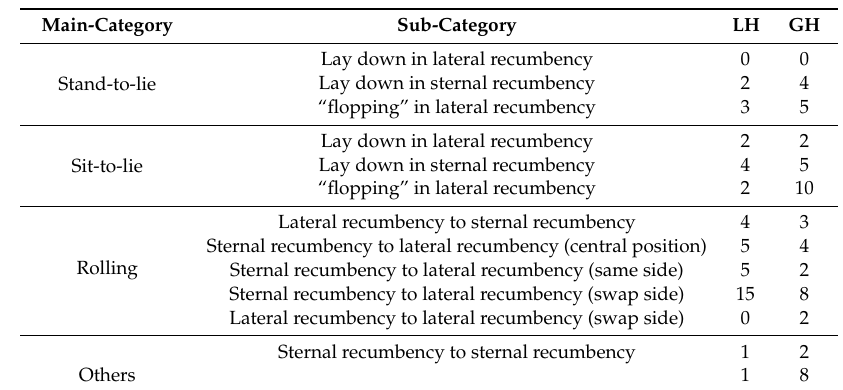
Table 2. Types and numbers of sows’ body posture changes that crushed piglets in single loose housing pens (LH; n = 44) and pens of the group housing system (GH; n = 55). Flopping means an uncontrolled fall down of the sow. Four GH-piglets were crushed in the common area after co-mingling and are not regarded in this table.